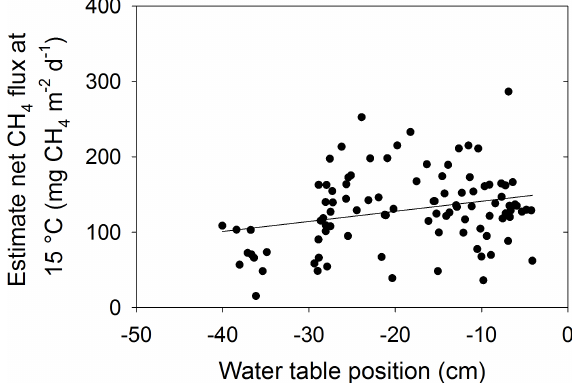
Fig. 5. The relationship between water table position and net CH 4 flux after accounting for mean daily air temperature. The net CH 4 flux at 15 ◦ C was estimated using the exponential equation relating mean daily air temperature to the CH 4 flux (Fig. 4). The difference between the measured and predicted net CH 4 flux was then used in the graph above to determine if water table position had an impact on the net CH 4 flux after mean daily temperature effects were ac- counted for. The linear regression is significant, but the data explain very little of the variance ( R 2 = 0 . 06). Positive CH 4 flux values rep- resent fluxes to the atmosphere and negative values represent losses from the atmosphere.